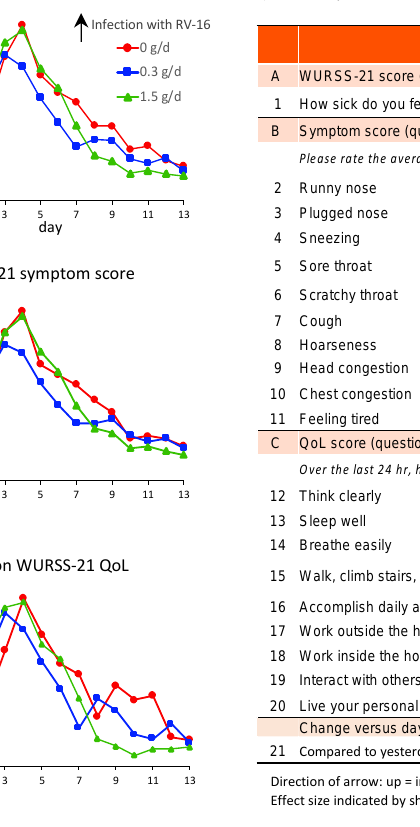
Figure 2. ( a ) Time course of WURSS-21 total score ( p < 0.001), ( b ) symptom score (sum question 2–11) ( p < 0.001) and ( c ) impact on QoL (sum question 12–20) ( p < 0.01), ( d ) Summary table of individual items in validated WURSS-21 questionnaire indicating significance in GEE analyses per item across all doses over the full time course. The stronger beneficial impact on reducing the severity of QoL attributes in the 1.5 g/d group is mainly attributed to the response observed after d8 in a limited number of subjects. For significant items with changes > 10%, the direction of change is indicated for the 0.3 and 1.5 g/d group relative to the 0 g/d